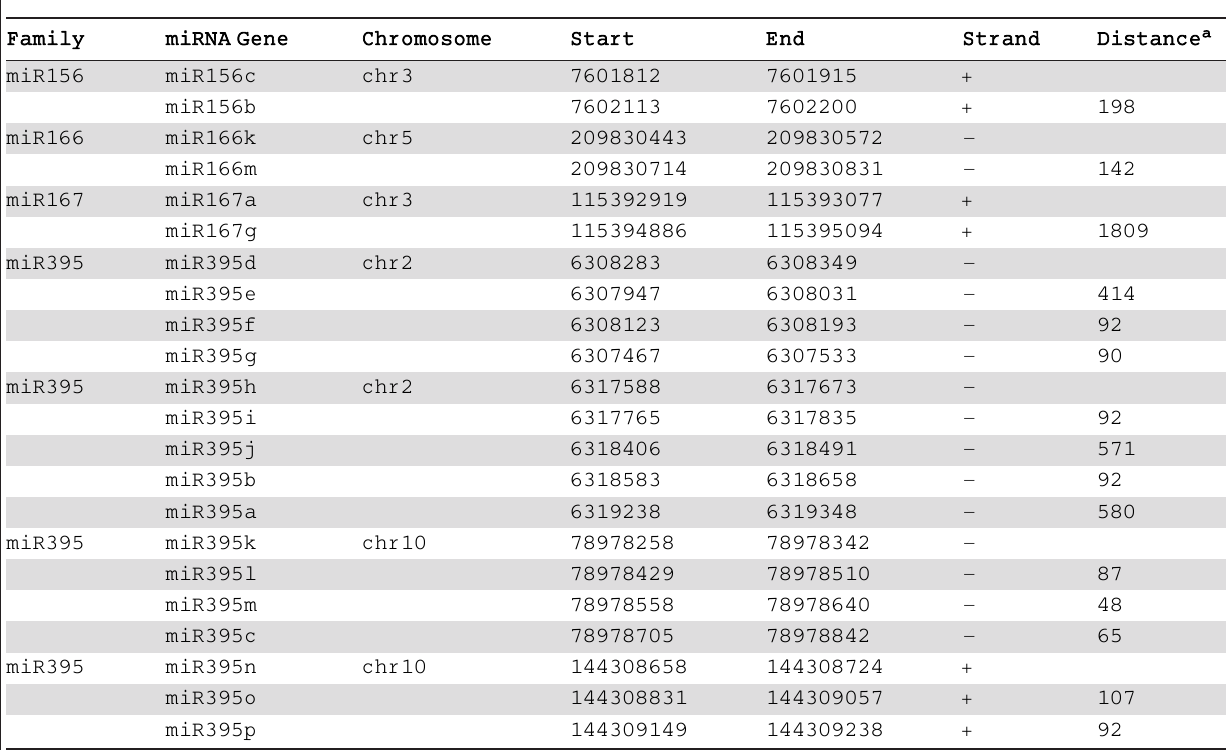
Table 2. Maize miRNA gene clusters.